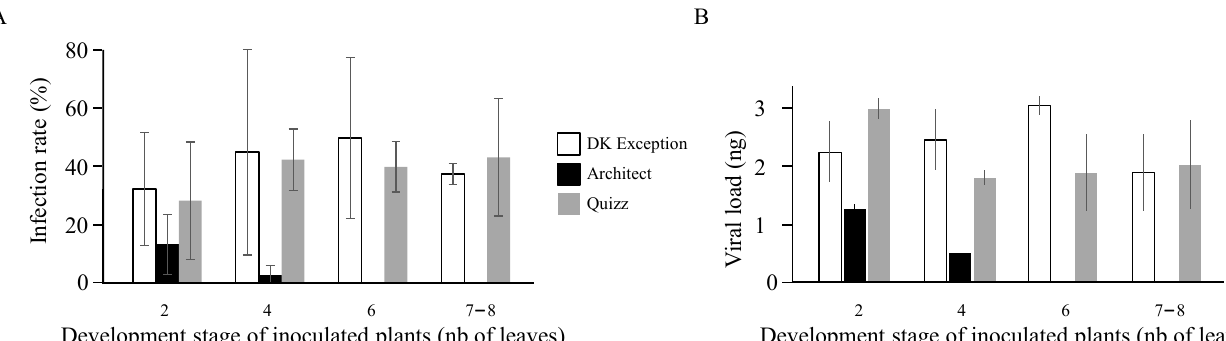
Figure 1. Infection rates of rapeseed genotypes ( A ) and virus load in infected plants ( B ) according to the development stage of plants at inoculation. Series of 20 plants at different development stages were inoculated with viruliferous (Turnip yellows virus, TuYV) aphids (2 aphids per plant) for 2 h inoculation access period. Three weeks after inoculation, the presence of TuYV in plants was tested by ELISA in the presence of standards corresponding to serially diluted fractions of purified TuYV-PS isolate. The positive threshold of the test was twice the OD 405 value of healthy plant controls with a minimum value of OD 405 = 0.1. The average infection rates ( A ) and the viral load in 100 µL of crude sap from infected plants ( B ) are presented. The experimental procedure was repeated at least twice for each genotype/developmental stage combination. The vertical bars represent the standard deviations associated with the data. At 4-leaves stage, only one out of the inoculated Architect plants was infected.